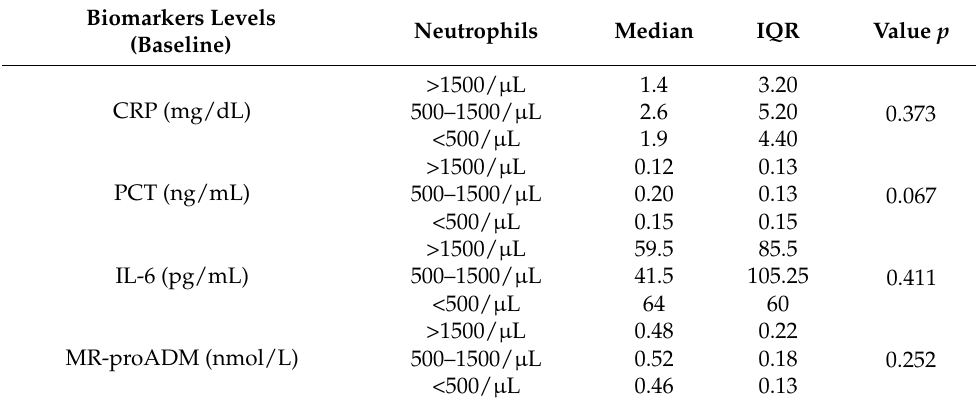
Table 4. Relation between C-reactive protein, procalcitonin, Interleukin-6 and midregional pro- adrenomedullin levels and number of